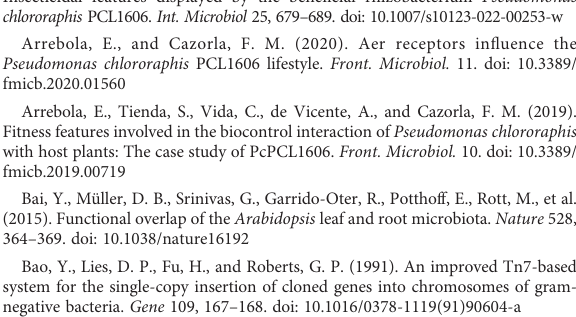
2D visualization under confocal laser microscopy of the bacterial population established on avocado roots after 24 hours. Pictures correspond to inoculated single, dual and triple combinations of P. chlororaphis strains. P. chlororaphis PCL1601 (red), P. chlororaphis PCL1606 (blue) and P. chlororaphis subsp. piscium PCL1607 (green). 3P: Three Pseudomonas sp. strains combined. Scale bars represent 80